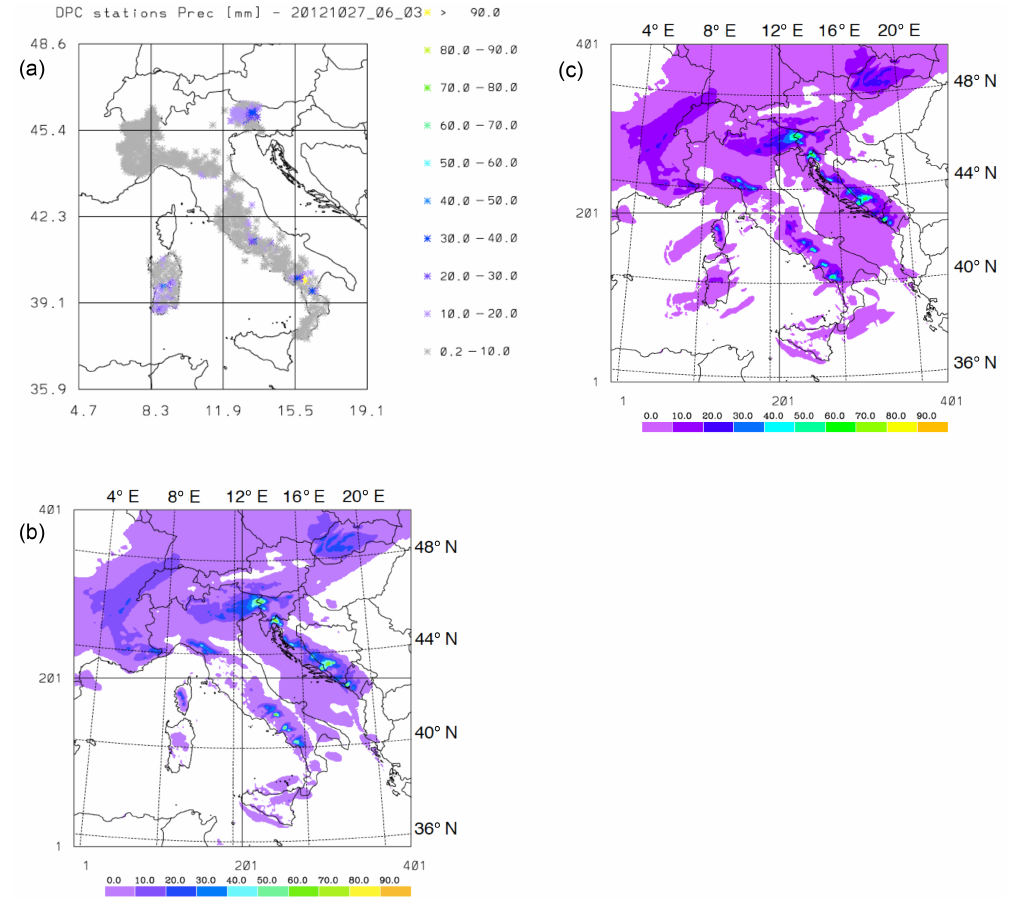
Figure 6. (a) Precipitation (mm) recorded by rain gauges between 06:00 and 09:00UTC; (b) as in (a) for the CNTRL forecast; (c) as in (a) for the F3HA6